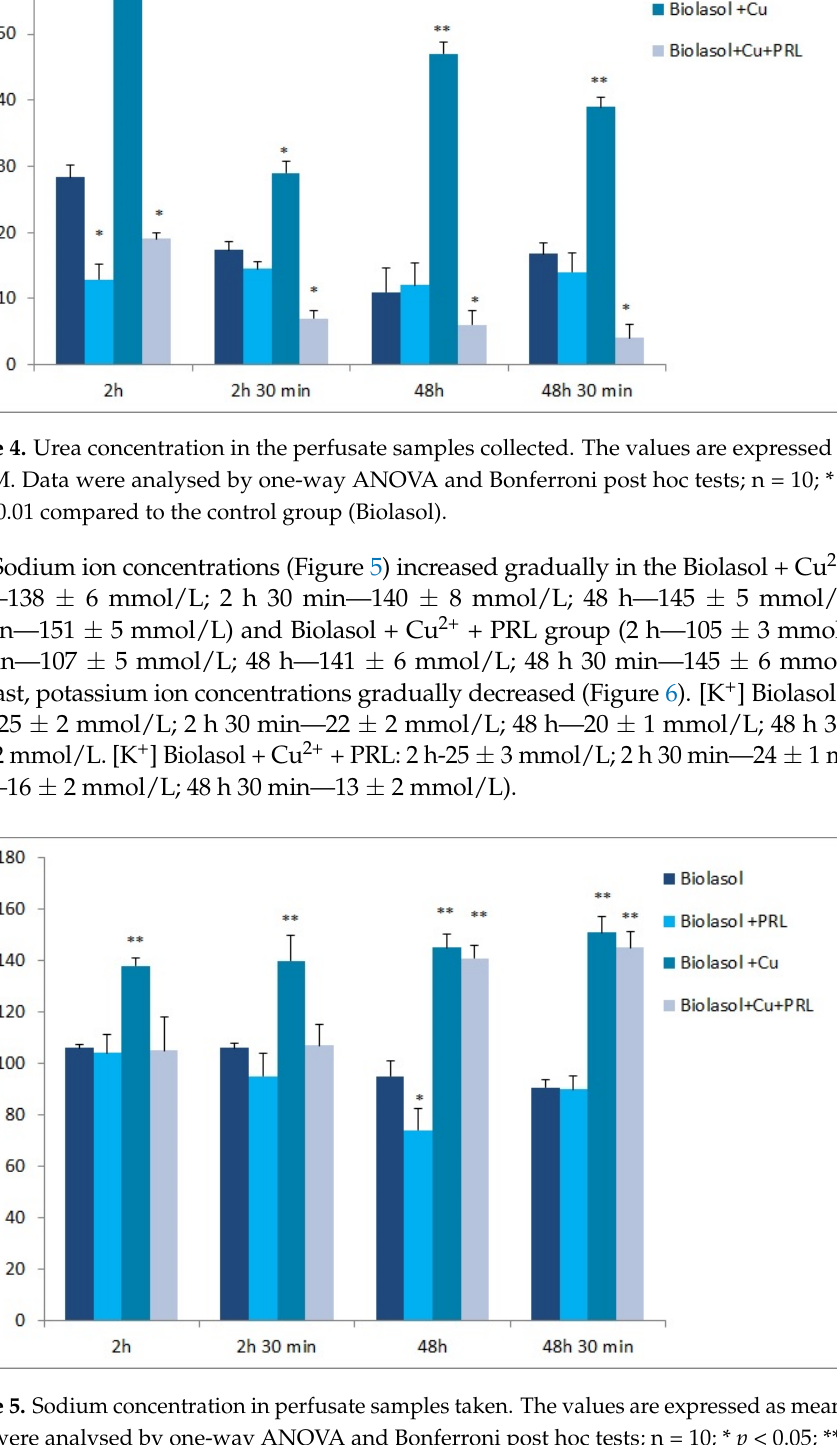
Figure 6. Potassium concentration in the perfusate samples collected. The values are expressed as mean ± SEM. Data were analysed by one-way ANOVA and Bonferroni post hoc tests; n = 10; * p < 0.05 compared to the control group (Biolasol). Figure 7 shows the concentrations of total protein and creatinine in the kidney ho- mogenates. The addition of copper to the Biolasol formulation increased the concentra- tions of total protein (2.7 ± 0.2 mg/g tissue; control group 2.5 ± 0.1 mg/g tissue, p < 0.05) and creatinine (3.1 ± 0.2 mg/g tissue; control group 2.5 ± 0.1 mg/g tissue, p < 0.01). The modification of Biolasol fluid with copper and prolactin also increased the analysed indi- ces. Total protein: 2.55 ± 0.2 mg/g tissue, control group 2.5 ± 0.1 mg/g tissue, p < 0.05. Cre- atinine: 2.95 ± 0.4 mg/g tissue, control 2.5 ± 0.1 mg/g tissue, p < 0.01).